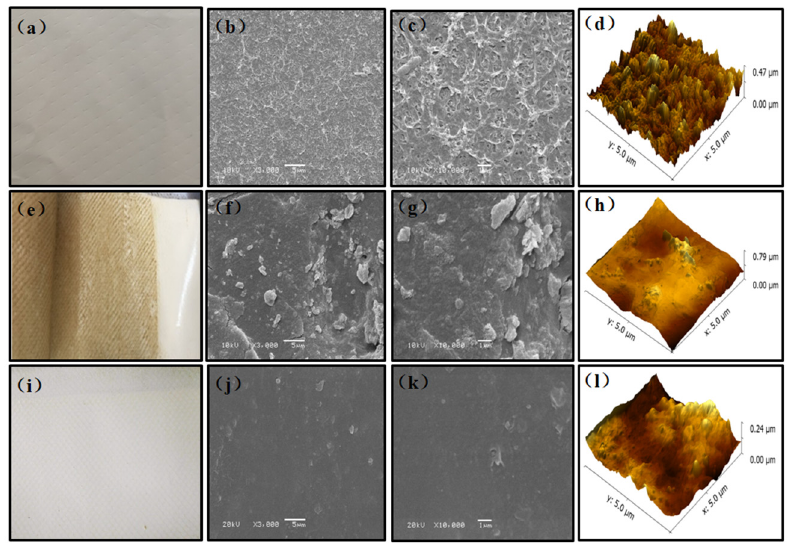
Figure 7. SEM and AFM images of virgin and fouled membranes. ( a – d ) Images of virgin NF; ( e – h ) images of fouled NF in SF+NF treatment; ( i – l ) images of fouled NF in SF+O 3 -BAC+NF